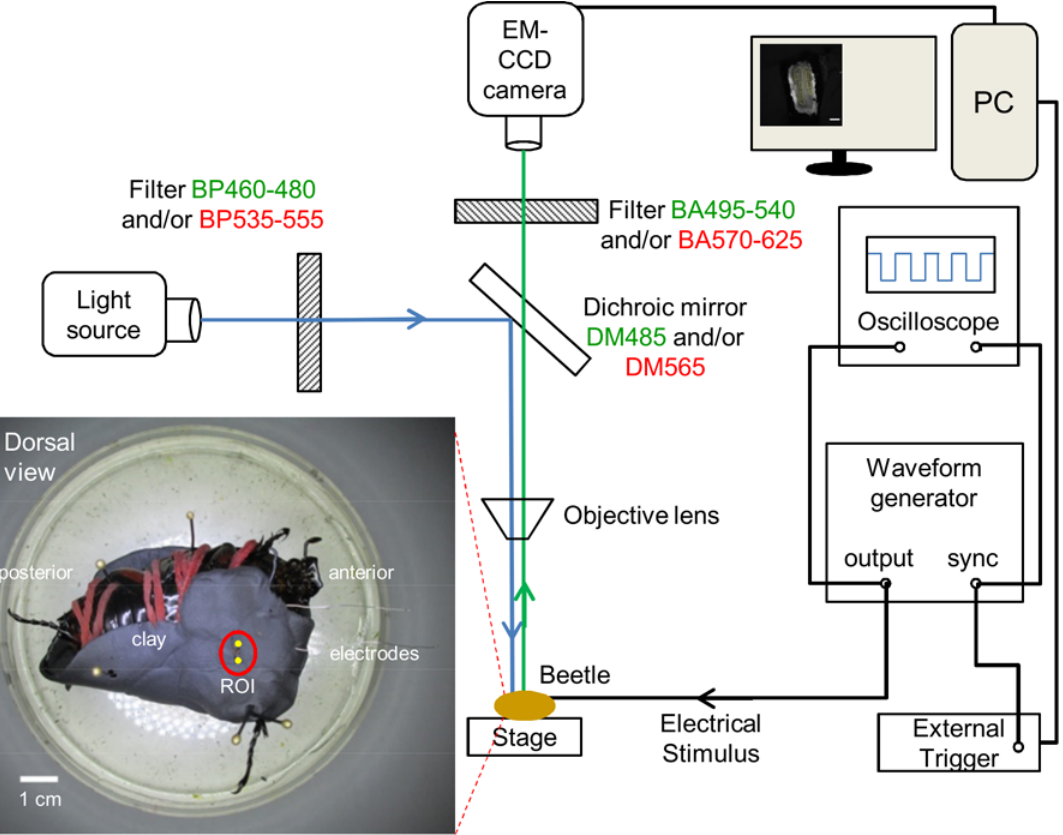
Figure 1. Illustration of fluorescence microscopy and electrical stimulation setups. The filter and mirror set in green font is used to observe Fluo-8, Rhodamine 123, and DiBAC 4 (3). The filter and mirror set in red font is used to observe Cell Tracker and Rhodamine B. Inset , dorsal view of the beetle fixed upside down on dissection plate using clay, rubber bands (in red), and insect pins. Two PFA-coated thin silver wire electrodes (one working electrode and one counter electrode) were inserted into the ends of the muscle that are marked by 2 yellow dots. The insertion depth is approximately 2 mm, as measured from the outer cuticle. The red circle indicates the observation window that was used to observe the flexion muscle, which located inside the femur of the beetle